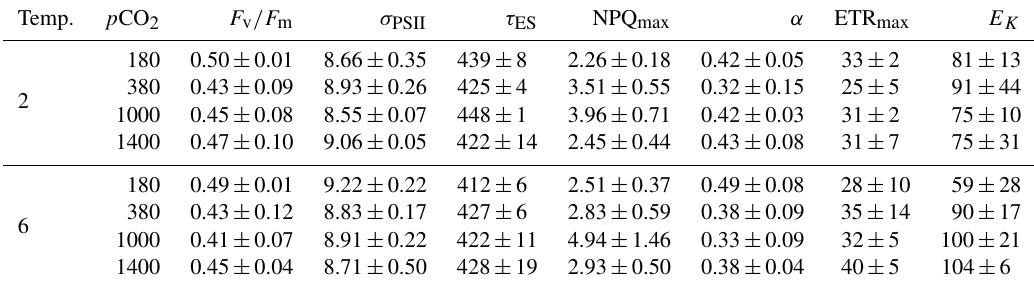
Table 3. FRR fluorometrical PSII photochemistry measurements – PSII quantum yield efficiency F v /F m (dimension- less), functional absorption cross section ( σ PSII ) (nm − 2 PSII − 1 ), rate of PSII re-opening ( τ ES , ms), maximum non- photochemical quenching at 672µmolphotonsm − 2 s − 1 (NPQ max , dimensionless), maximum light-use efficiency (initial slope α , mole − m 2 ( molRCII ) − 1 ( molphotons ) − 1 ), maximal absolute electron transfer rates through PSII (ETR max , mole − ( molRCII ) − 1 s − 1 ),